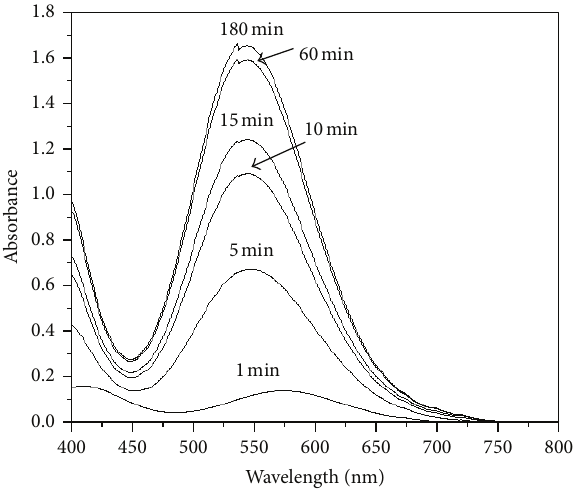
Figure 6: UV-Vis spectra of the Cr-EDTA complex at 70 ∘ C.